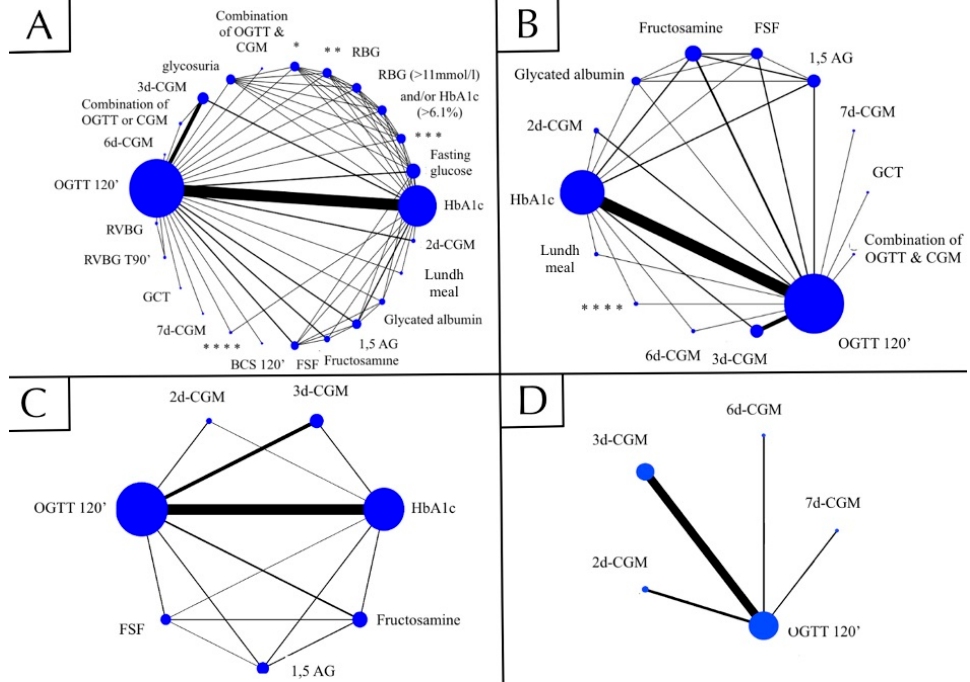
Figure 2. Network graphs. Network graphs show comparisons between examined diagnostic tests and OGTT T120 ′ , used as reference standard. In the network graph, direct comparisons are shown with lines, and the thickness of the lines represents the number of the head-to-head trials, and the size of the nodes correlates with the number of studies. ( A ) Network A summarizes all included studies ( n = 31), comparing 24 different index tests to the reference standard. ( B ) Network B assesses studies after excluding those, which raises potential risk for overlapping populations. In this net- work, comprising 25 studies, 13 index tests were compared to the reference standard. ( C ) Network C represents studies ( n = 23) that analysed index tests ( n = 6), which had been used in at least two different articles from the study pool of Figure 2B. ( D ) Network D represents studies evaluating different durations of CGM, and included articles ( n = 10) from the Figure 2B study pool.Abbrevia- tions: d = days; CGM = continuous glucose monitoring; FSF = fractional serum fructosamine; 1;5-AG